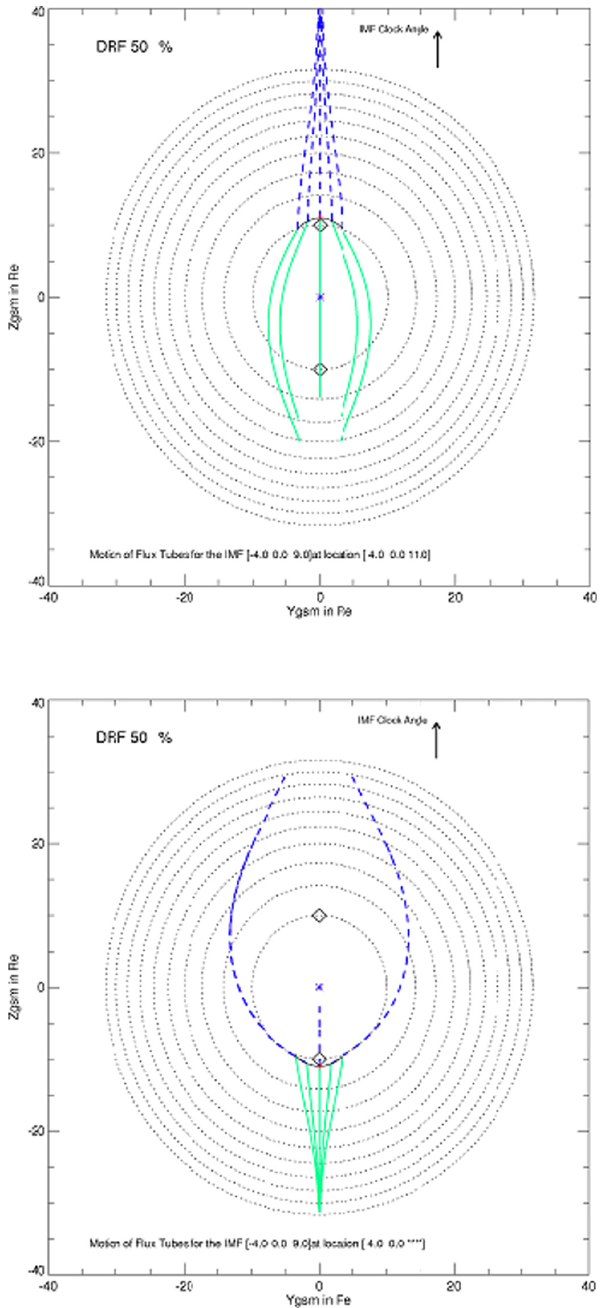
Fig. 9. Output of the Cooling model for a IMF of ( − 4, 0, 9)nT in GSM, corresponding to the prevailing IMF when SC3 crosses the cusp, and for a reconnection site poleward of the northern cusp (top) and poleward of the southern cusp (bottom). The blue dashed and green solid lines show the path of newly-reconnected field lines from the X-line (black solid lines).